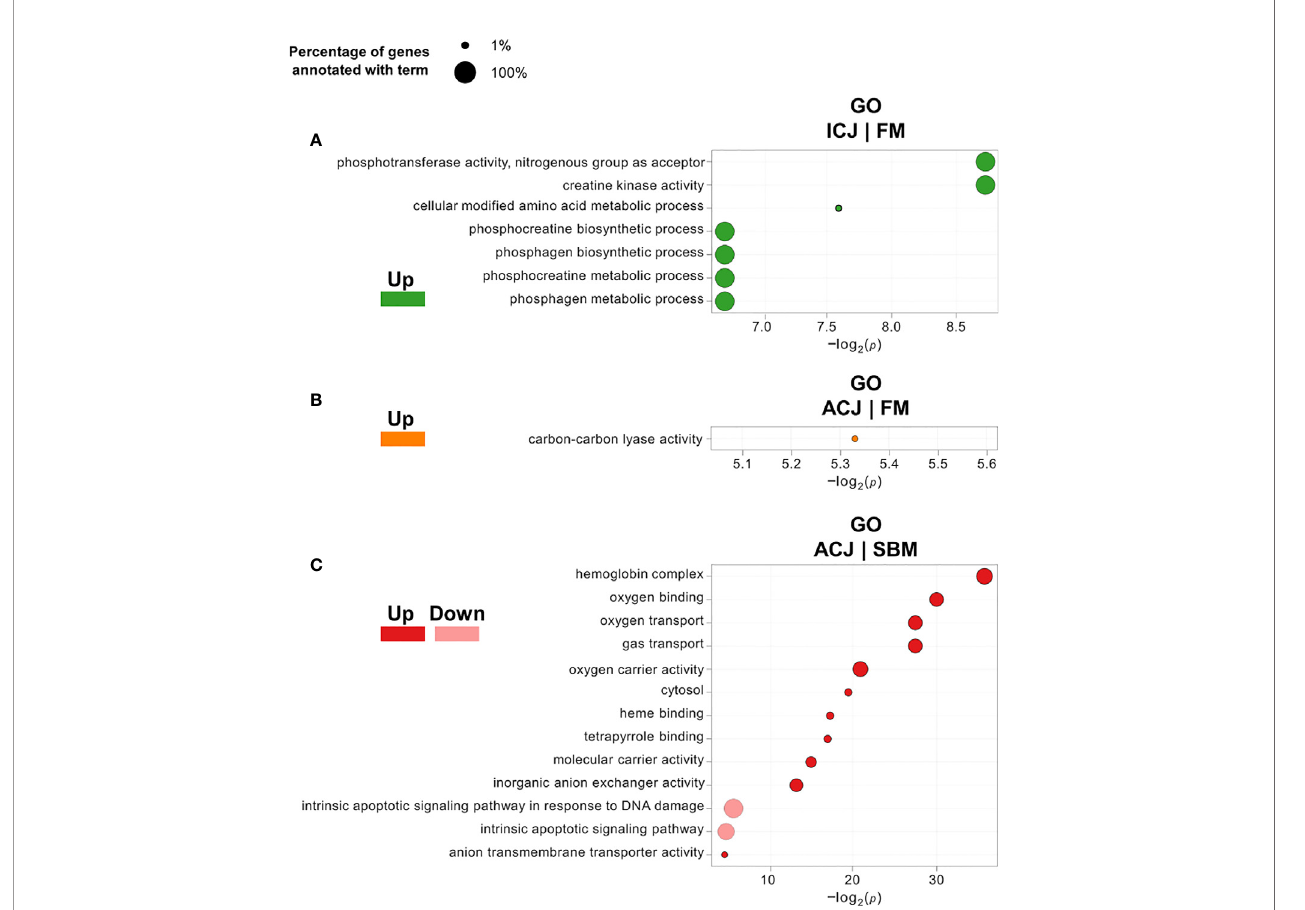
FIGURE 2 | Signi fi cantly enriched gene ontology (GO) terms (minGSSize = 3) in spleen of fi sh fed C. jadinii diets compared to control diets (FM and SBM). The list is ordered by -log 2 ( p ). (A) GO terms in ICJ compared to FM. Up, up-regulated (in green). (B) GO terms in ACJ compared to FM. Up, up-regulated (in orange). (C) GO terms in ACJ compared to SBM. Up, up-regulated (in red); Down, down-regulated (in